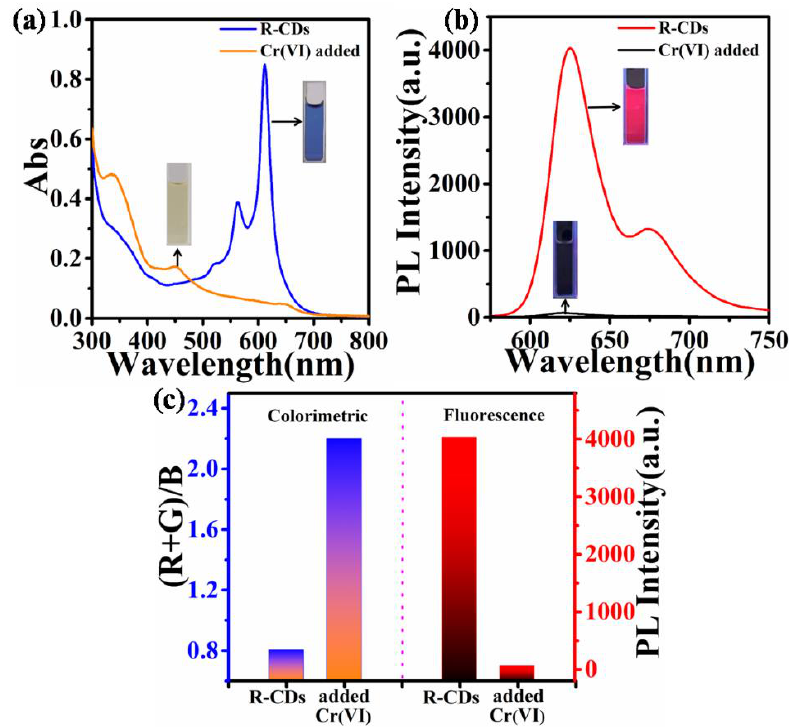
Figure 3. The UV-visible absorption ( a ) and PL spectra ( b ) of R-CDs before and after Cr(VI) addition, and the intensity change corresponding to a and b ( c ). The response mechanism of R-CDs to Cr(VI) also was speculated based on a series of experiments, which should be mainly attributed to the unique oxidability of